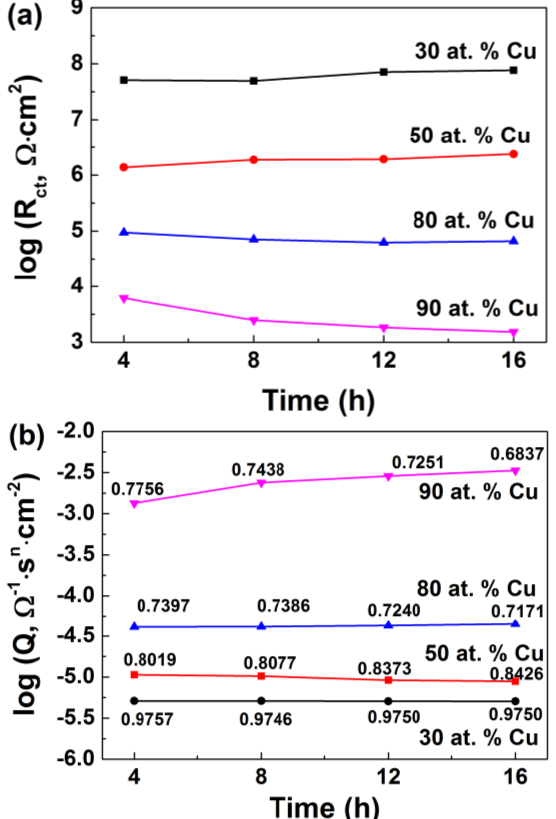
Figure 10. R ct and Q values versus time plots of Zr-Cu glassy coatings within 16 h; ( a ) R ct values; ( b ) Q values; the digits are the fitted n values.